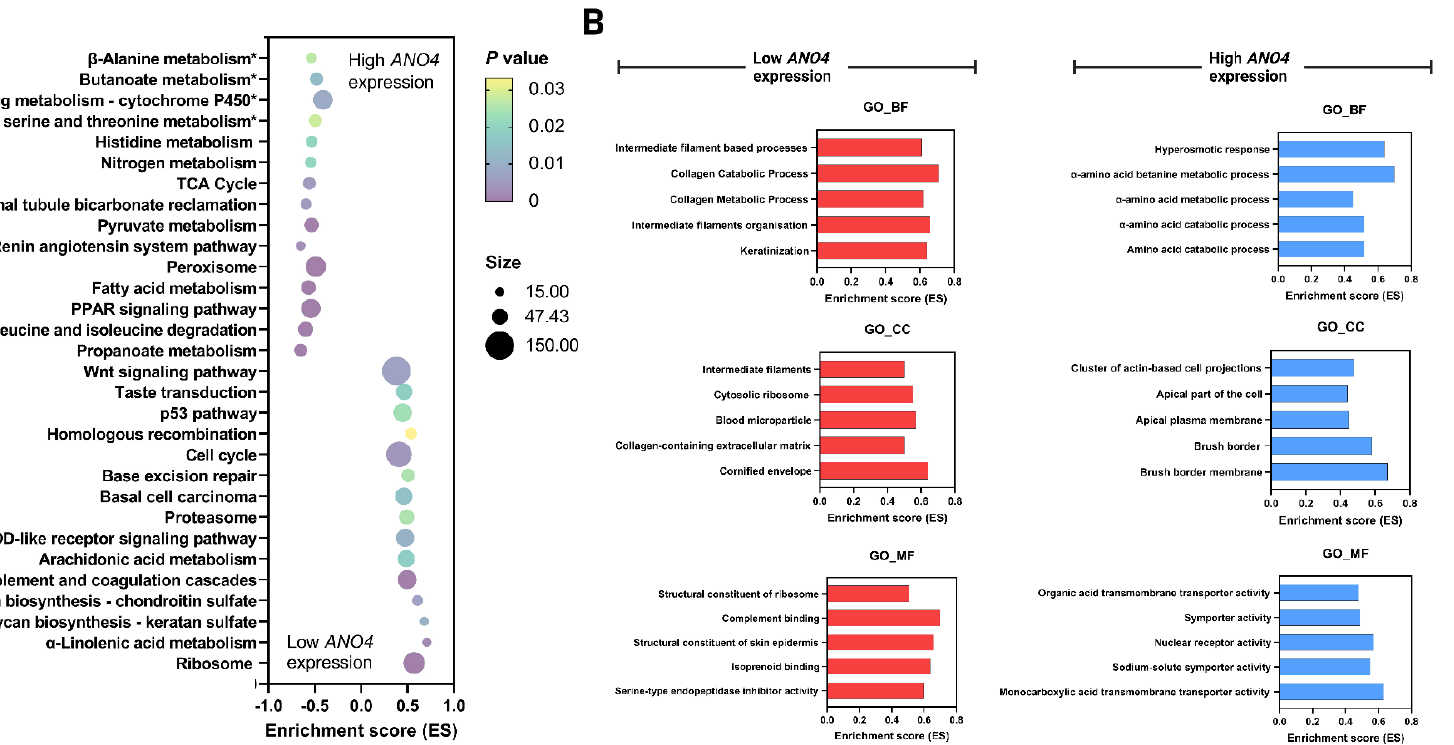
Figure 4. Bubble plot illustrating the top 15 KEGG pathways enriched within the low and high ANO4 expression groups ( A ). Top five biological processes (BP), cellular components (CC), and molecular functions (MF) enriched within the low and high ANO4 expression groups ( B ). * Denotes for an FDR > 25%.